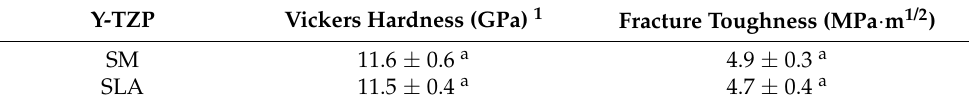
Figure 7. SEM images of the SM ( a ) and SLA ( b ) Y-TZP ceramic surfaces showing Vickers indentations and cracks. The right is a magnification of the crack marked with a red square in the left image (left: magnification: 300×, scale bar = 20 μ m; right: magnification: 10,000×, scale bar = 1 μ m). Table 3. Vickers hardness/fracture toughness of the SM- and SLA-fabricated Y-TZP ceramics. Y-TZP